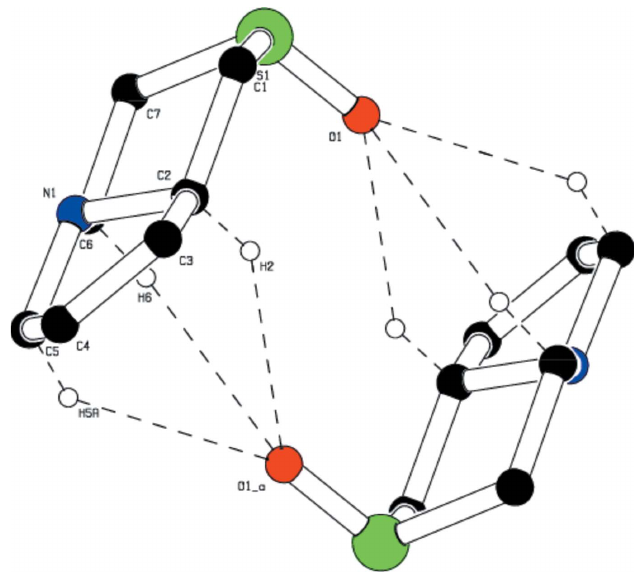
Figure 3 Trifurcated hydrogen bond involving donor atoms C2,C5 and C6 with oxygen atom O1 as acceptor.